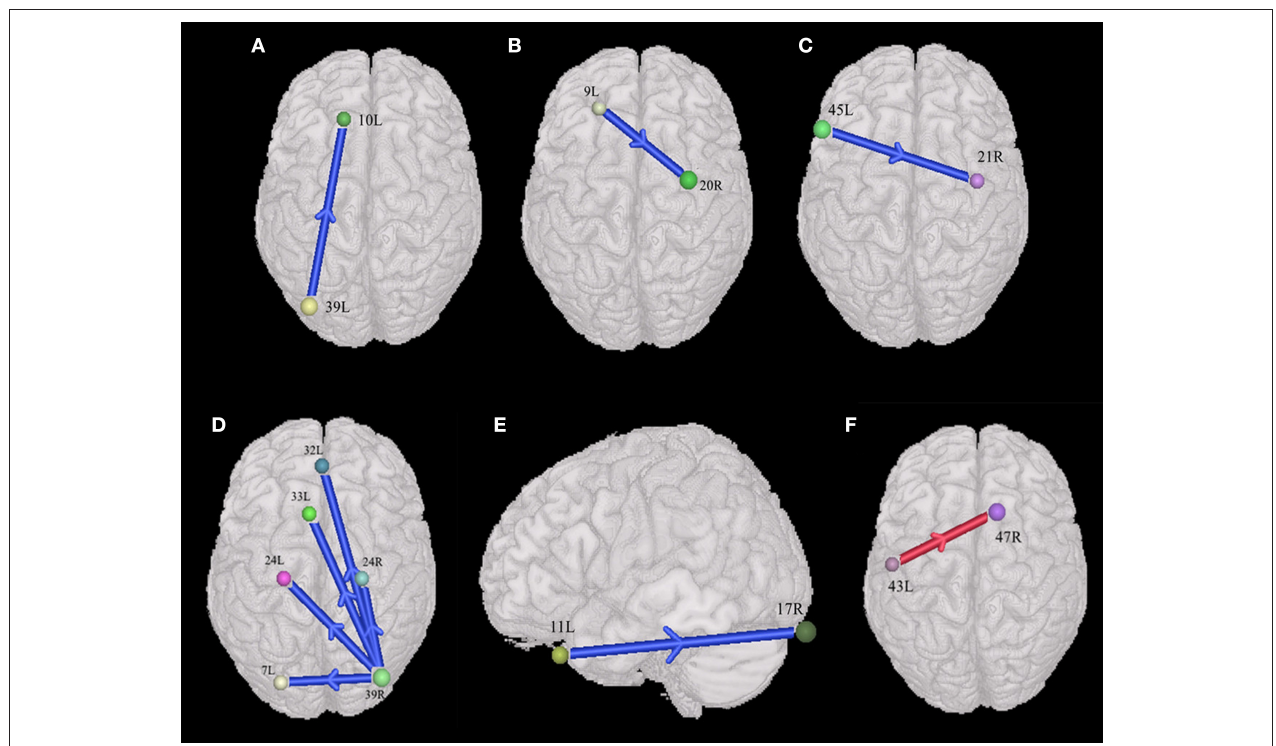
FIGURE 4 | Sex-specific differences of the entropy connectivity in ASD ( p < 0.05, two-sided, PRT corrected; reproducible rate: 0.85; number of subjects: 30; PRT threshold: 1,000). (A–E) Synchronous entropy connectivity in the male group. (F) Synchronous entropy connectivity in the female group. The red arrow denotes enhanced interregional connection. The blue arrows denote weakened interregional connections. Every colored sphere in the figure indicates the seed brain region of entropy connectivity, and the color of the sphere is randomly generated and has no special meaning. The number next to the sphere is the index of BA (see Table 2 for details). The direction of the arrow indicates the direction of directional